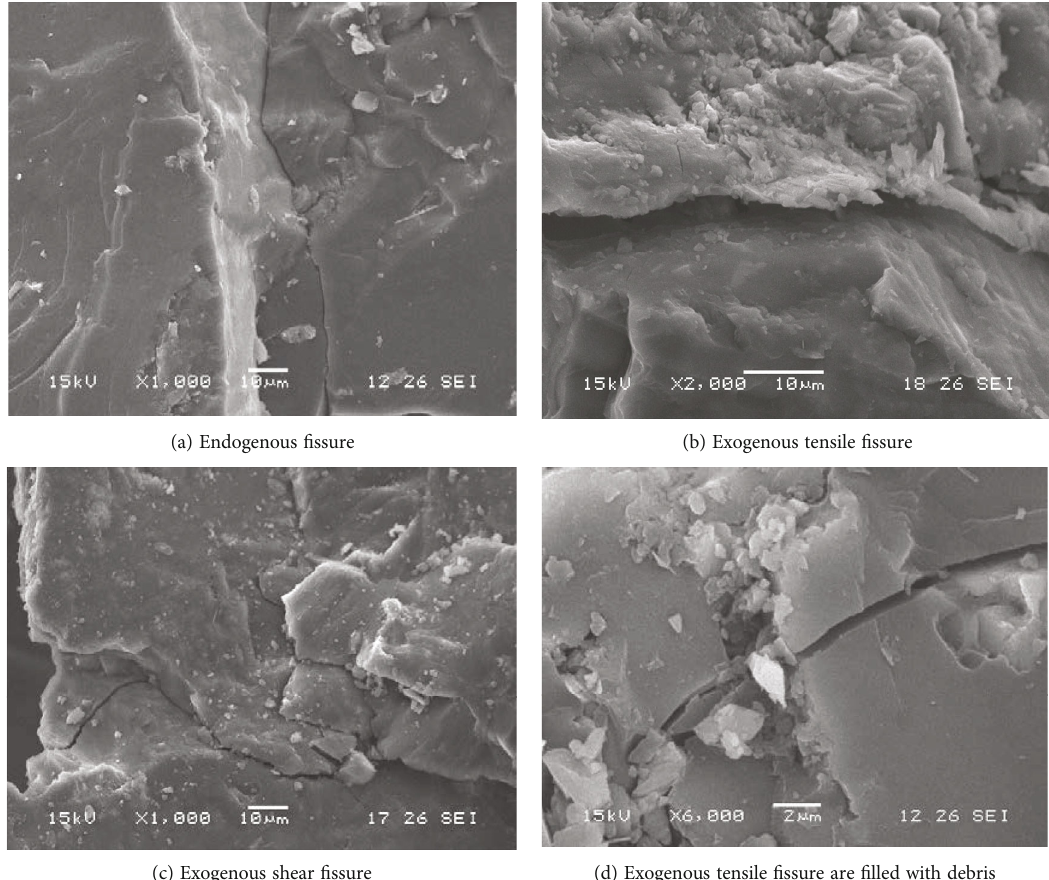
Figure 4: Fissure characteristics under scanning electron